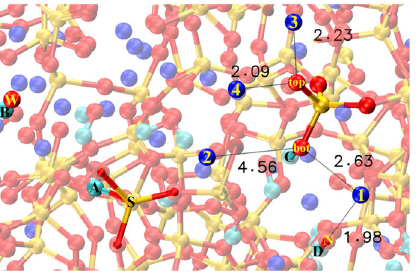
Fig. 6 Representative con fi guration after the self-exchange silanol re-formation. A, B represent two hydrogen atoms from the initial water molecule and 1, 2, 3, 4 represent four sodium ions involved in the ion-exchange process. An additional water molecule